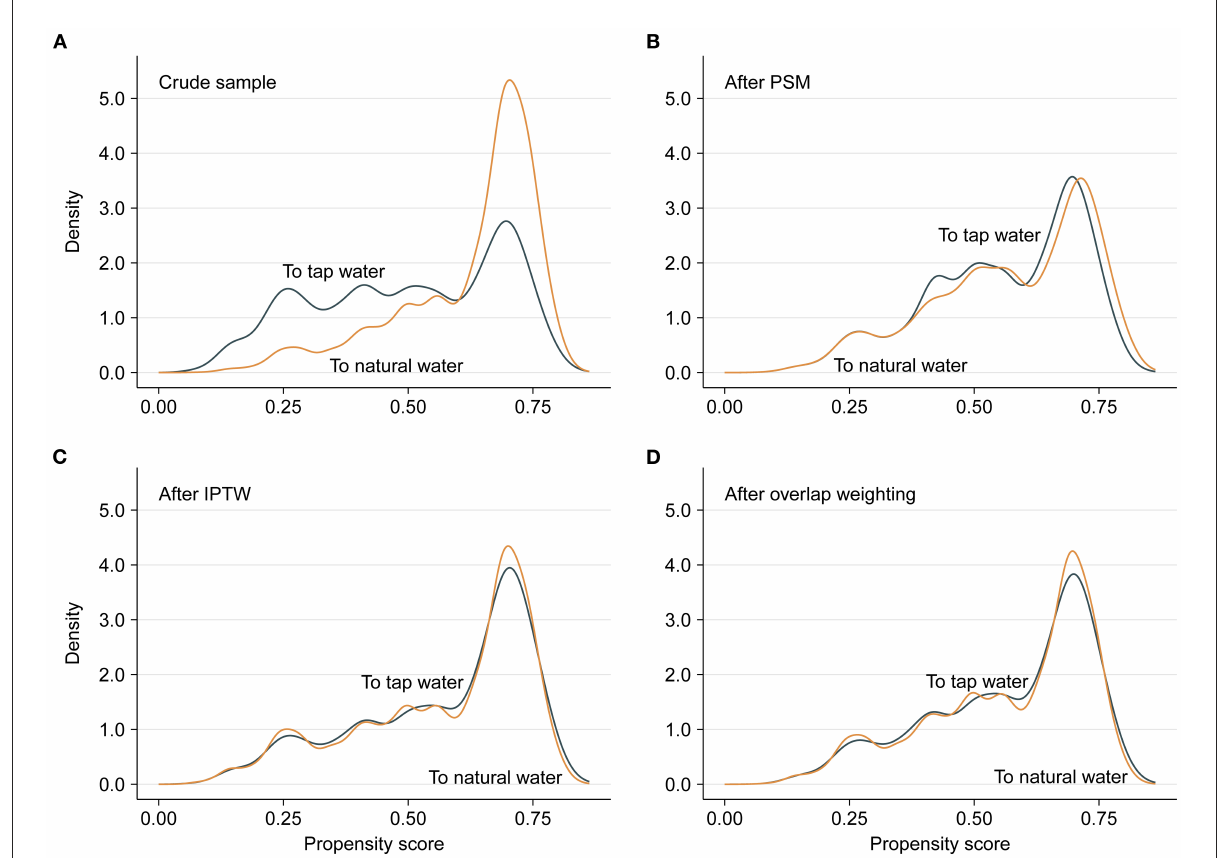
FIGURE3 Propensity score distributional overlap before and after matching or weighting. (A–D) present propensity score distributions between the participants who drank natural water unchangeably and the participants who switched to tap water in the crude sample, PSM sample, IPTW sample and overlap weighting sample. For intervals along the x-axis, the area under the probability density curve represents the probability of those propensity scores, and smoothing was via the kernel density estimate. Greater overlap of propensity score curves of the two groups indicates a lesser risk of